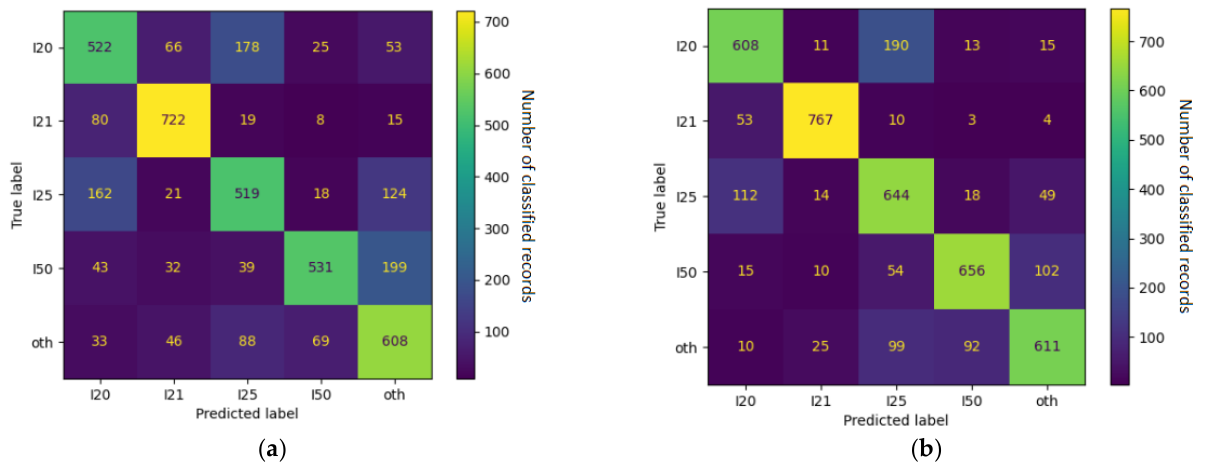
Figure 3. Confusion matrices for the 4 + 1 models trained on ( a ) admission data and ( b ) discharge data. Numbers refer to counts of examples in the respective categories, and the color spectrum reflects the contrast in their proportions.